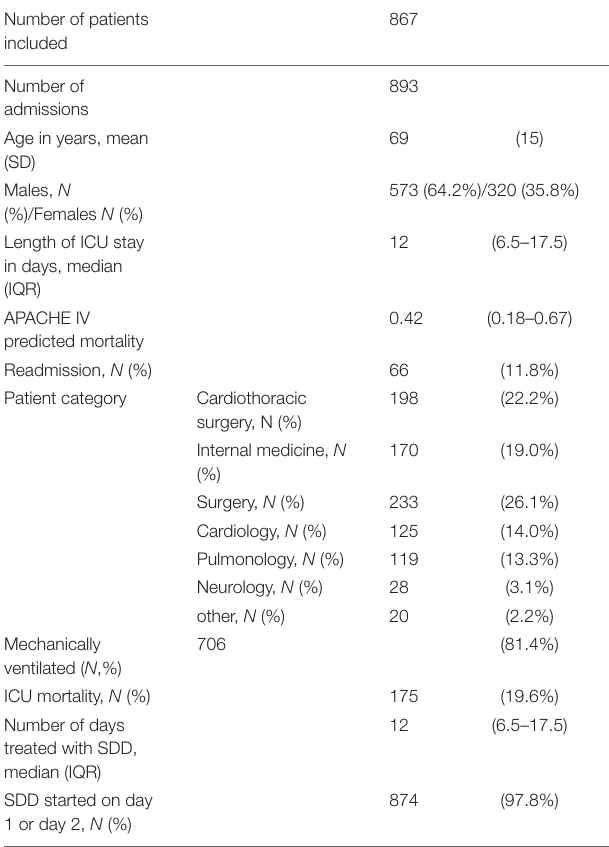
TABLE 2 | Baseline